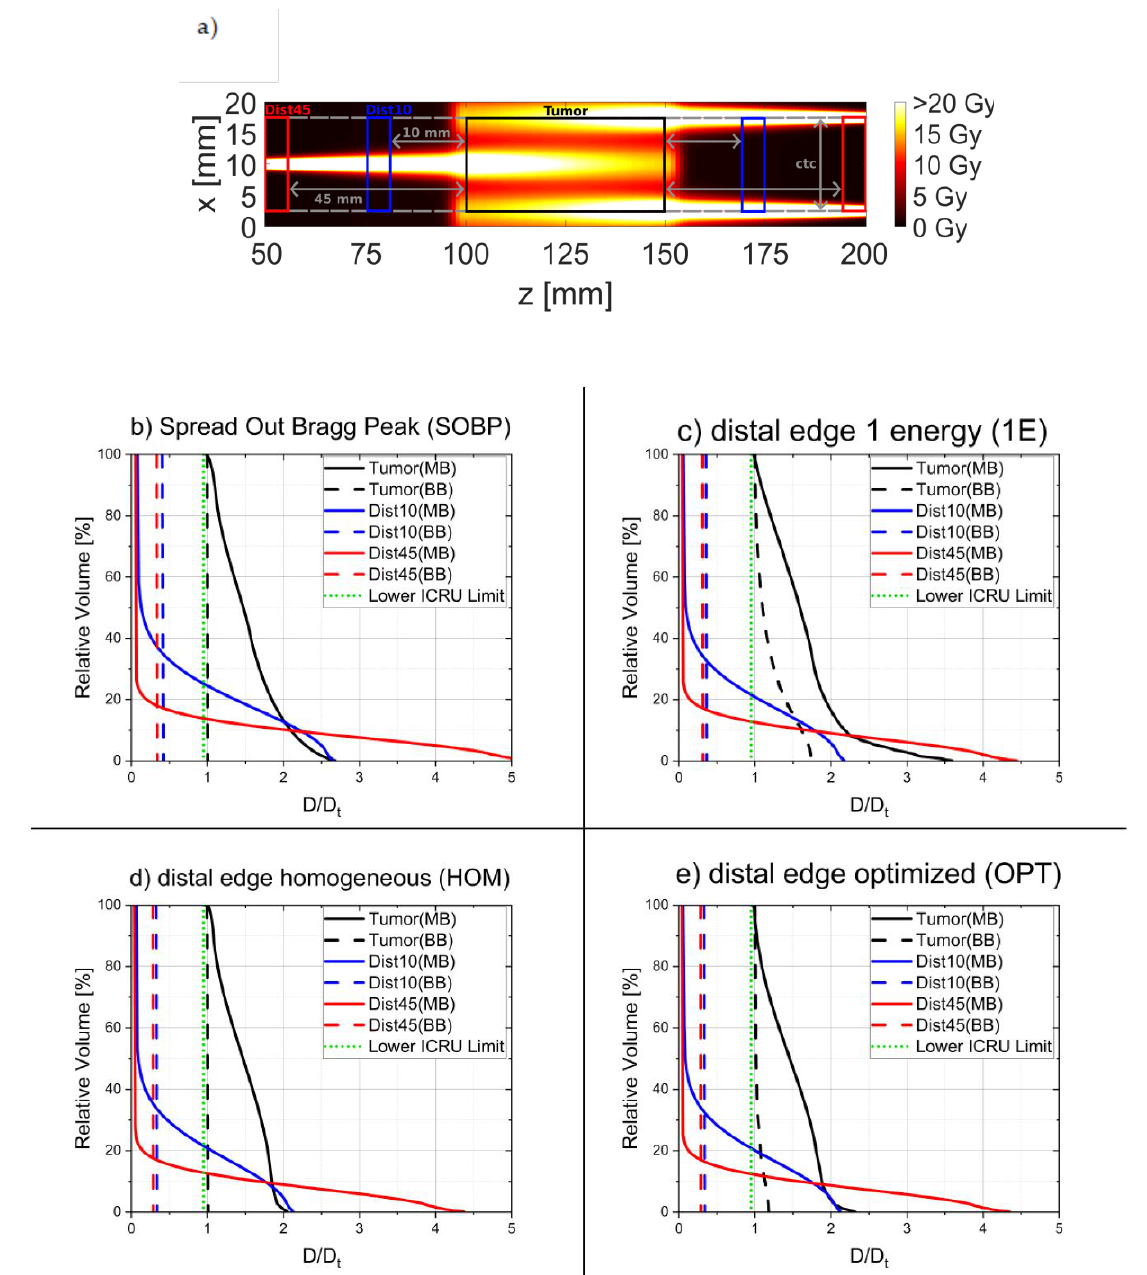
Figure 4. Dose-volume histograms ( b – e ) of the regions marked in ( a ) for the four considered longitudinal irradiation modes, for both the broadbeam (BB) and minibeam (MB). The lower dose limit of D/D t = 0.975in the tumor is displayed in green.